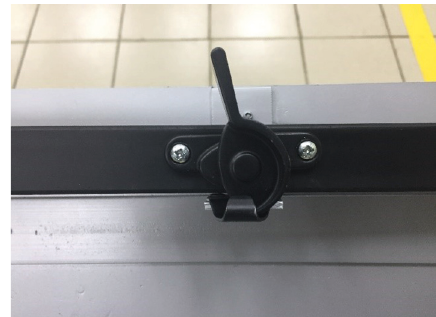
Figure 8: Locate and secure the outer skin aircraft door using a quick-acting latch clamp.